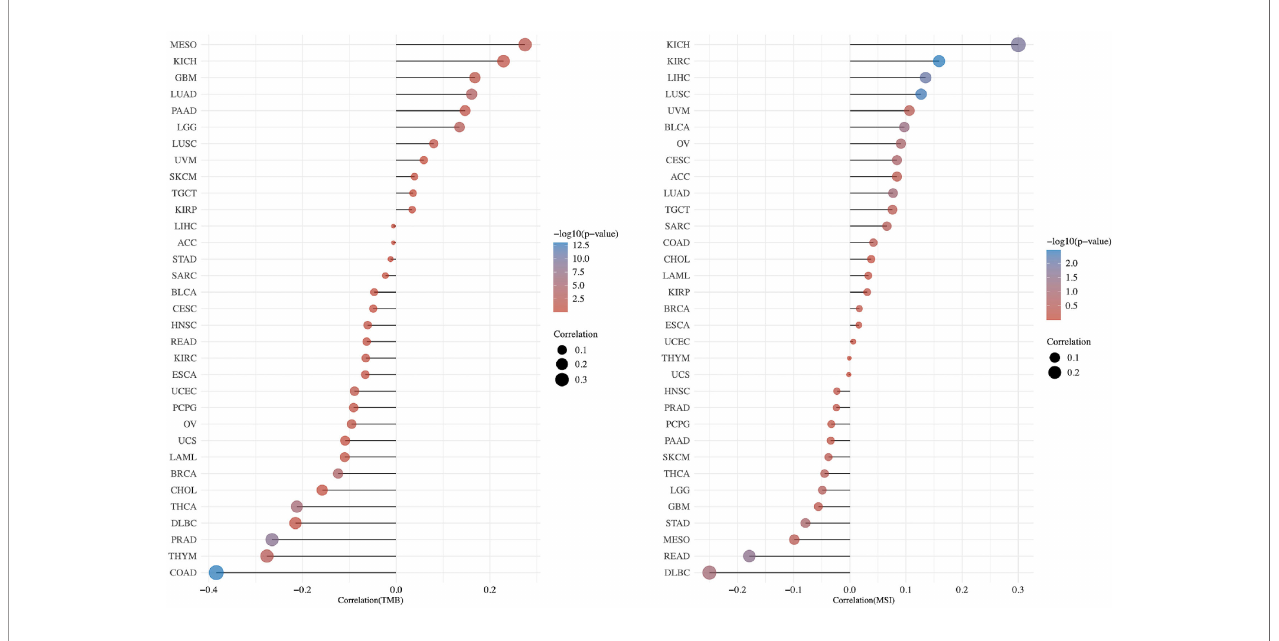
FIGURE 7 | Correlation between PCIF1 and TMB and MSI in TCGA tumors.